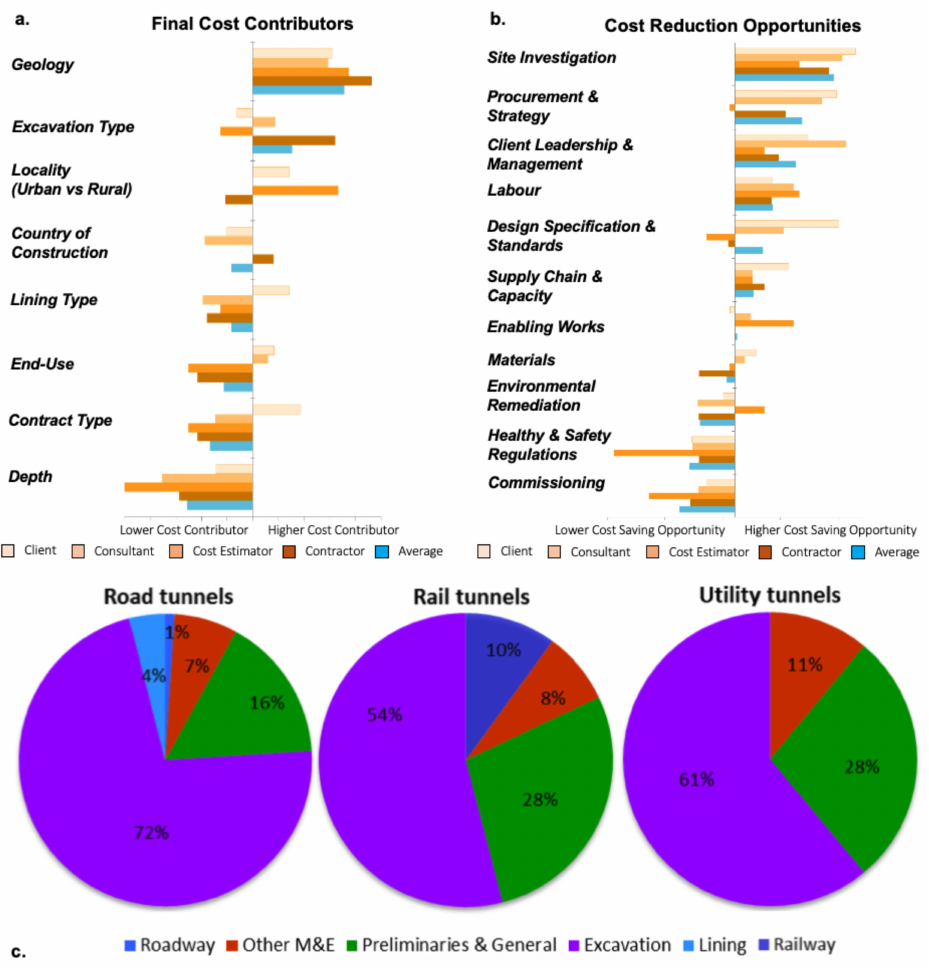
Figure2. ( a )CostContributorsintunnellingprojects, ( b )costreductionopportunitiesand( c )breakdown of construction cost composition (modified from